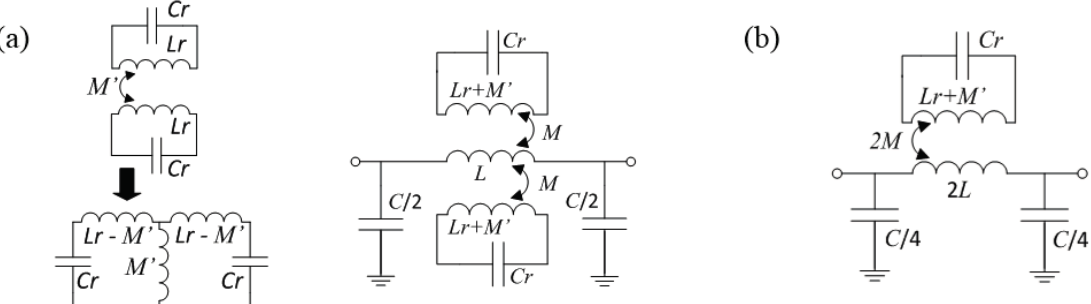
Figure 14. ( a ) Circuit model of the structure of Figure 13 for the symmetric case, with the inductive coupling between resonators transformed to the equivalent T-model (indicated on the left); ( b ) circuit that results by applying the magnetic wall